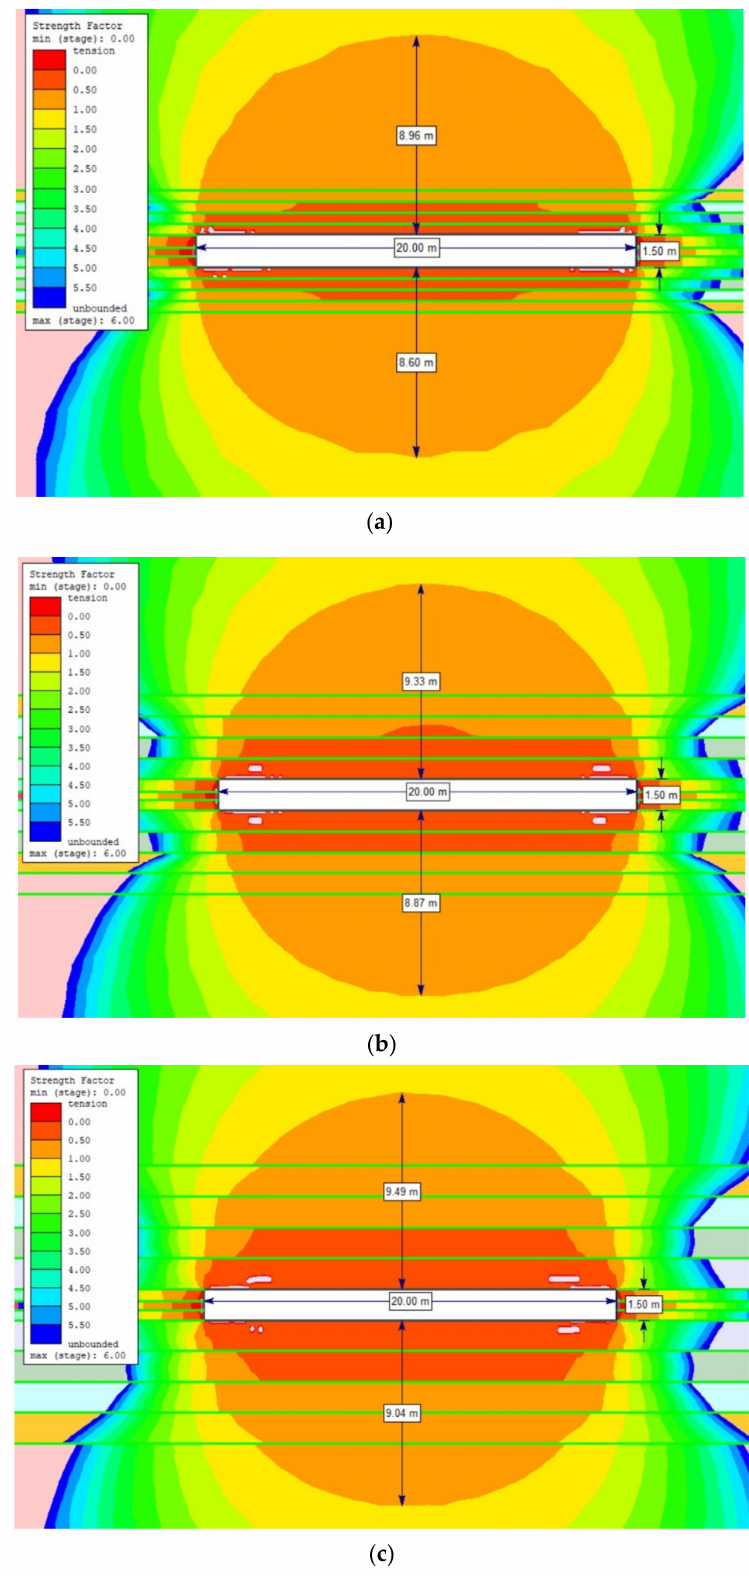
Figure 14. The extent of the rock destruction zone around the gasification channel with a width of 20 m and the impact of temperature of 1200 ◦ C for the dry rock mass, up to the height of: ( a ) 0.5 m; ( b ) 1.0 m; ( c ) 1.5